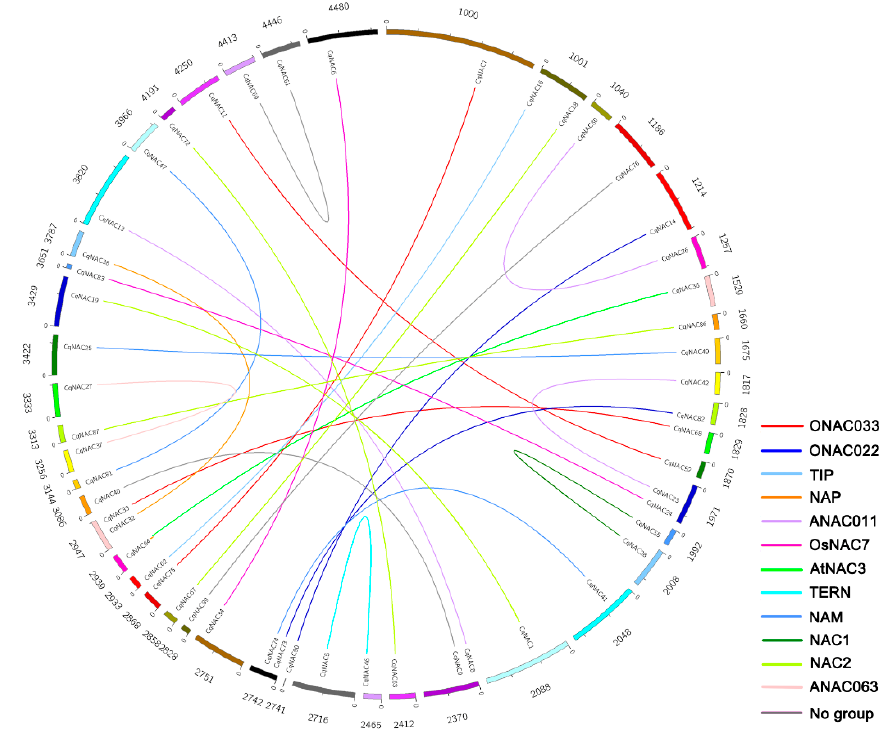
Figure 3. Distribution of 28 duplicated NAC gene pairs in quinoa. The numbers represent the scaffolds of quinoa which CqNACs are located in. The duplicated gene pairs are joined by colored lines. The differently colored lines represent the subfamilies within the CqNAC family.